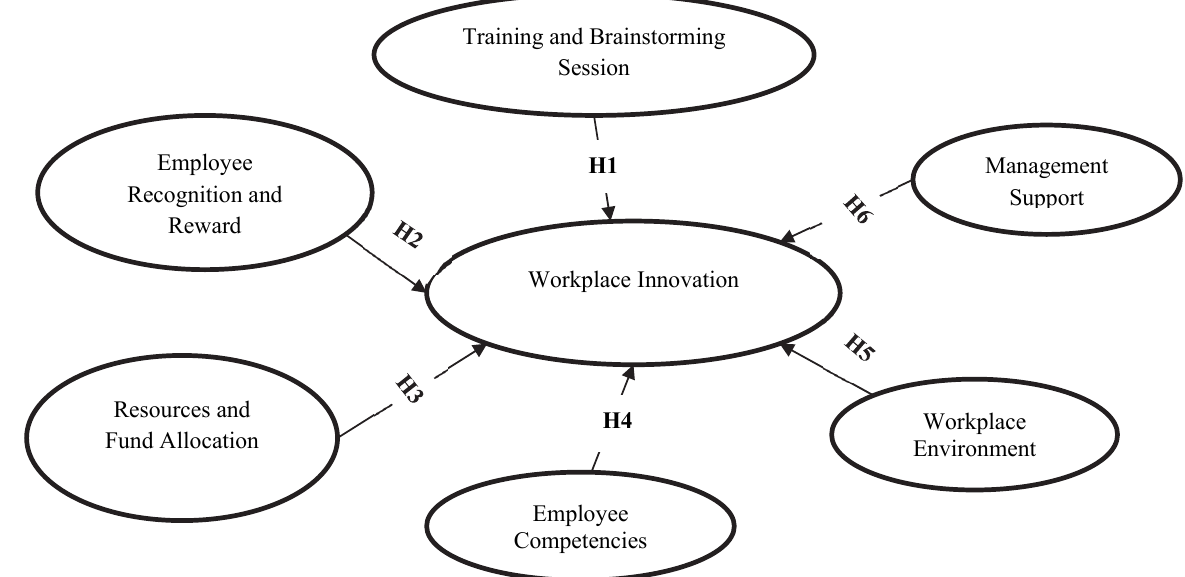
Fig. 1. A proposed theoretical model of employees’ creativity and innovation at